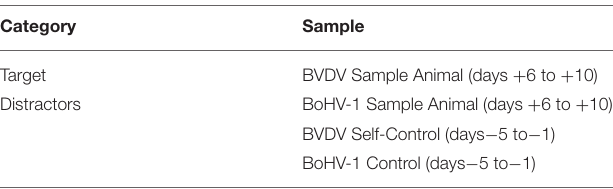
TABLE 2 | Sample POCR generalization testing list. Each set of targets and distractors were used across each sample